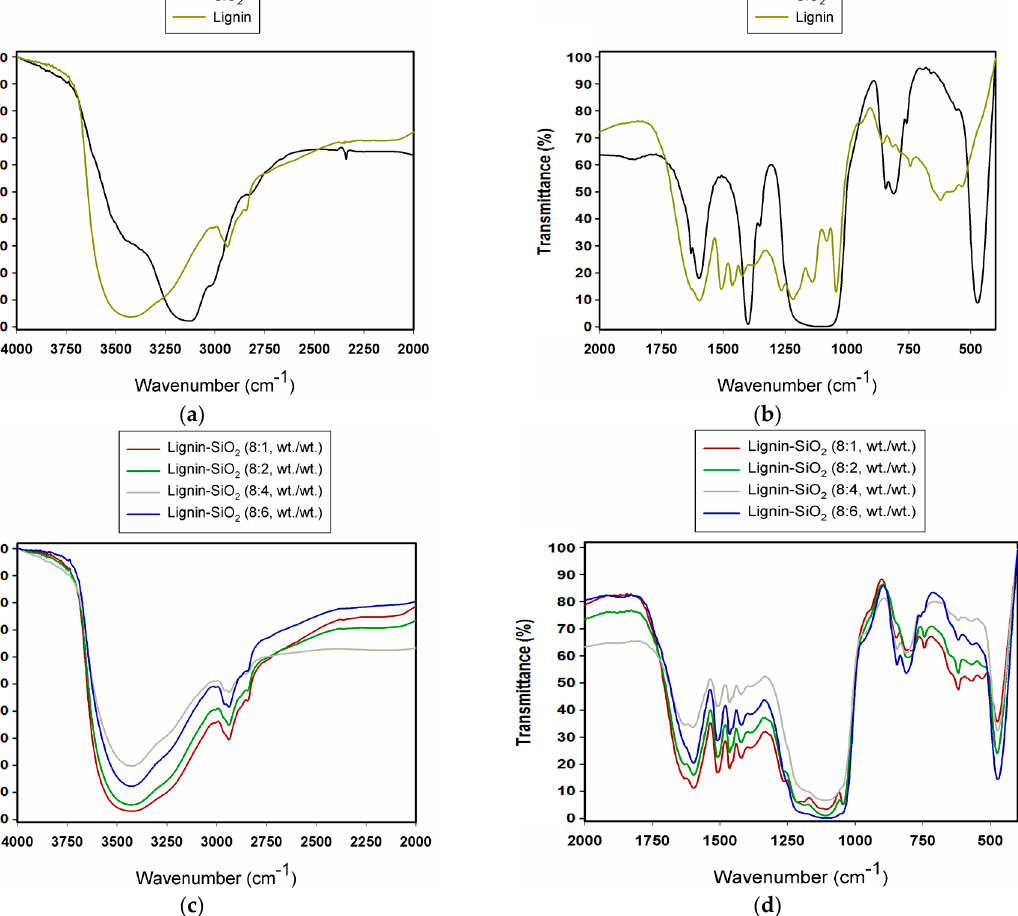
Figure 1. FT-IR spectra of: the precursors silica and lignin ( a , b ); and lignin–silica hybrid materials ( c , d ).